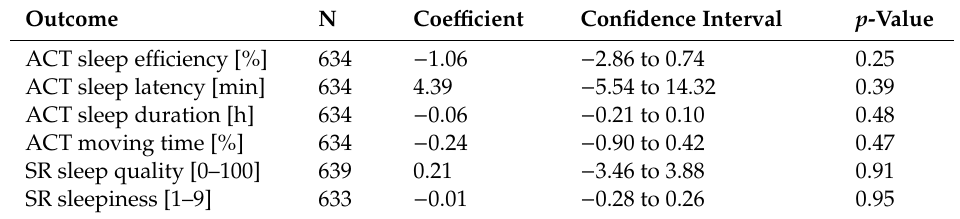
Table 4. Adjusted association between sleep outcomes and estimated indoor nighttime noise (L eq,night ) per 10 dB(A) increase.